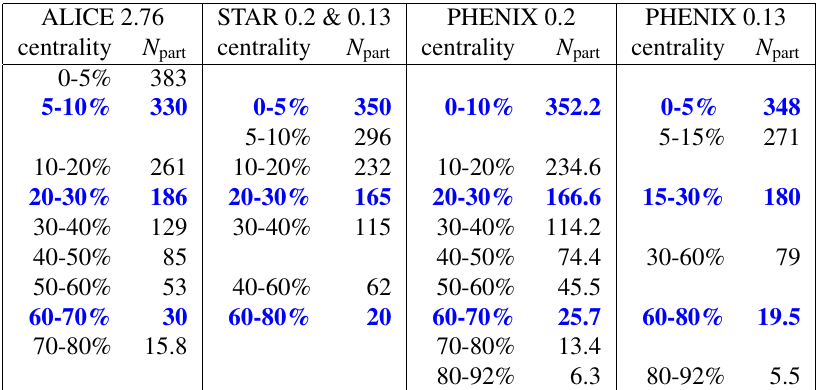
Table 1. Centrality classes and the corresponding numbers of participants in heavy ion experiments analysed in this paper. Energies per nucleon in TeV are displayed next to the experiment name. Bold face entries in blue (color on-line) show classes of similar number of participants analysed in the